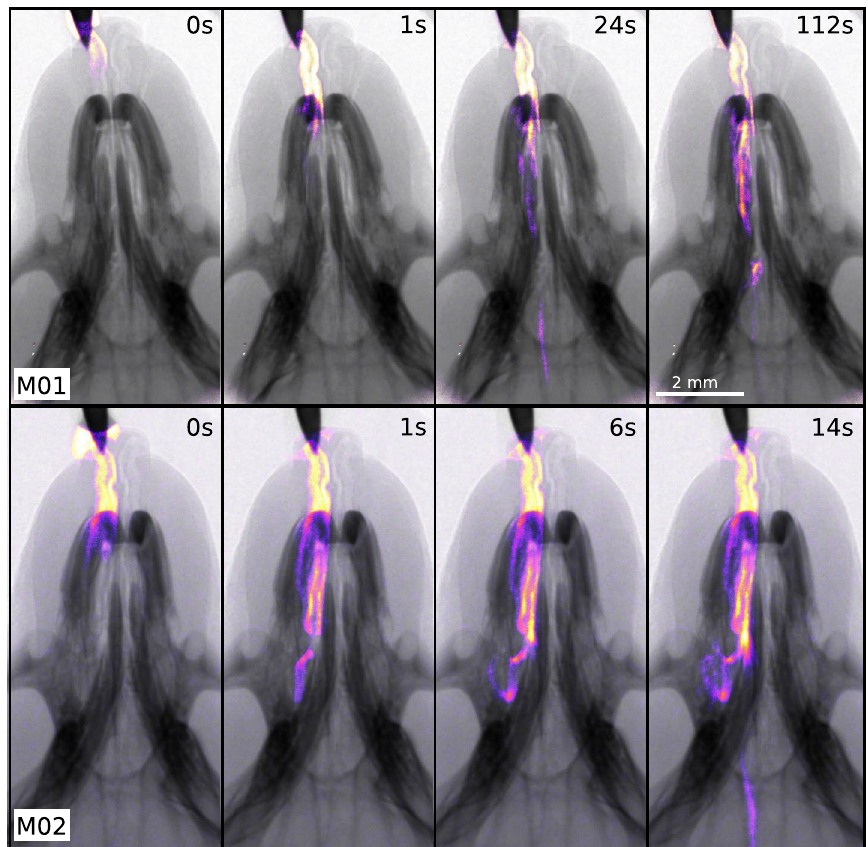
Figure 3. Delivery of liquid instillations to the nose of a mouse. The first row shows four time points during a relatively slow delivery of 20 µ l of fluid over 500 s into one nostril of mouse M01. The second row shows the faster delivery, 40 µ l in 250 s (mouse M02). The pseudo-coloured images show the fluid distribution. The origin of time axis was chosen at the point in time when the mouse inhaled the first liquid